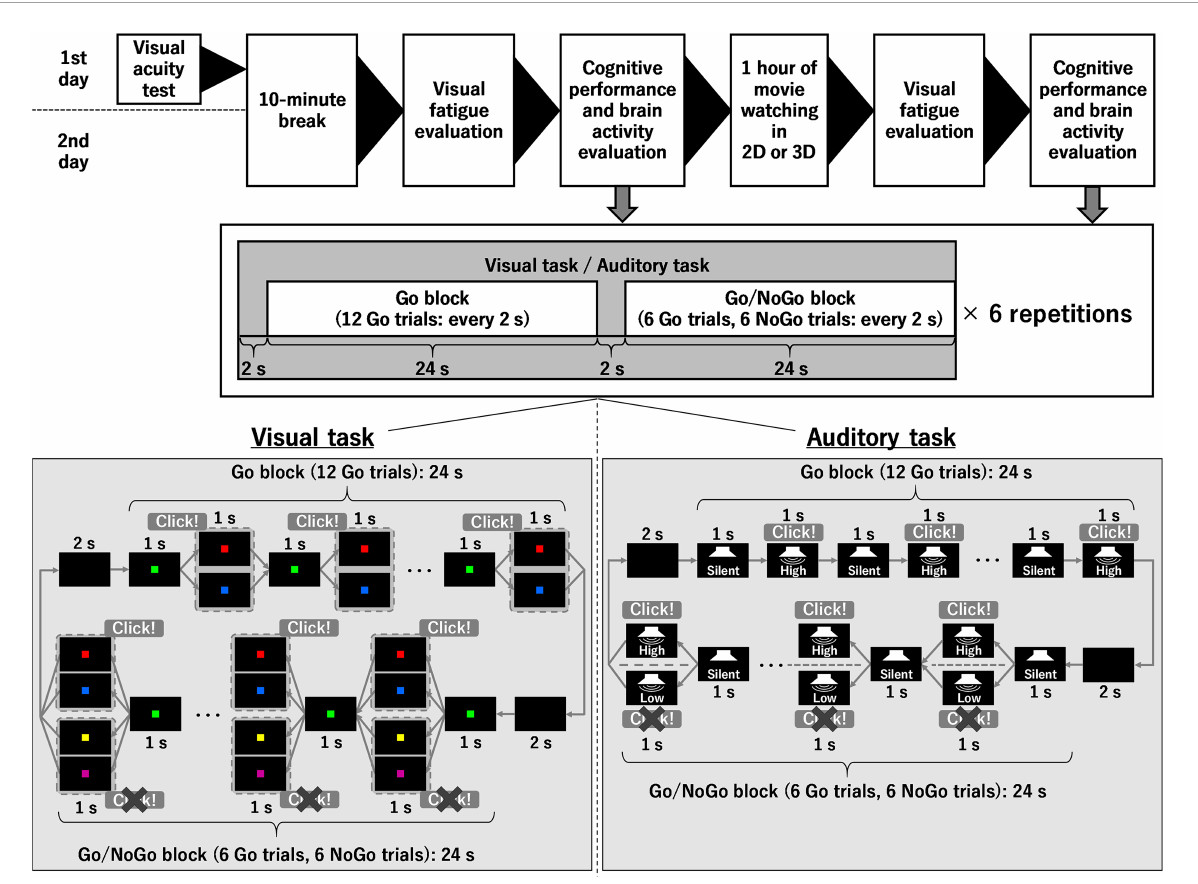
FIGURE1 Experimental procedure and stimuli during cognitive tasks. 2D, two-dimension; 3D,